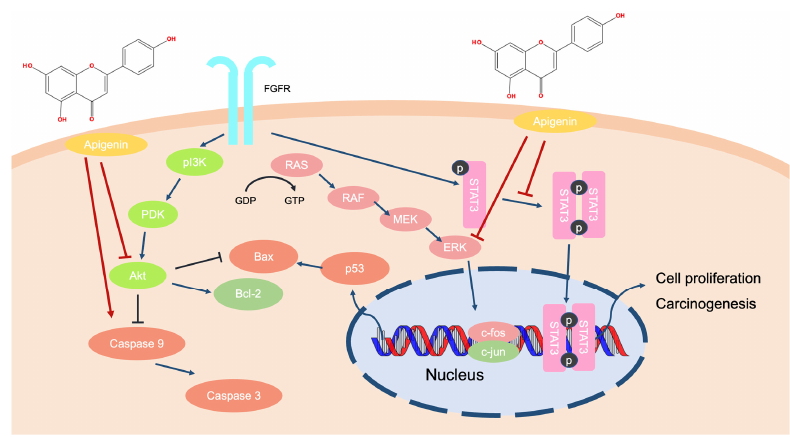
Figure 8. The molecular process of apigenin in melanoma cells.